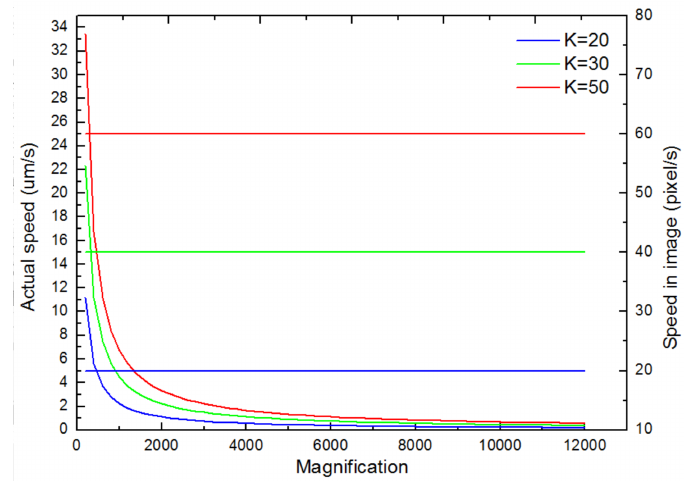
Figure 8. The relationship between the X-axis actual speed and relative speed in SEM imaging with an increase in magnification value, when k was set to different